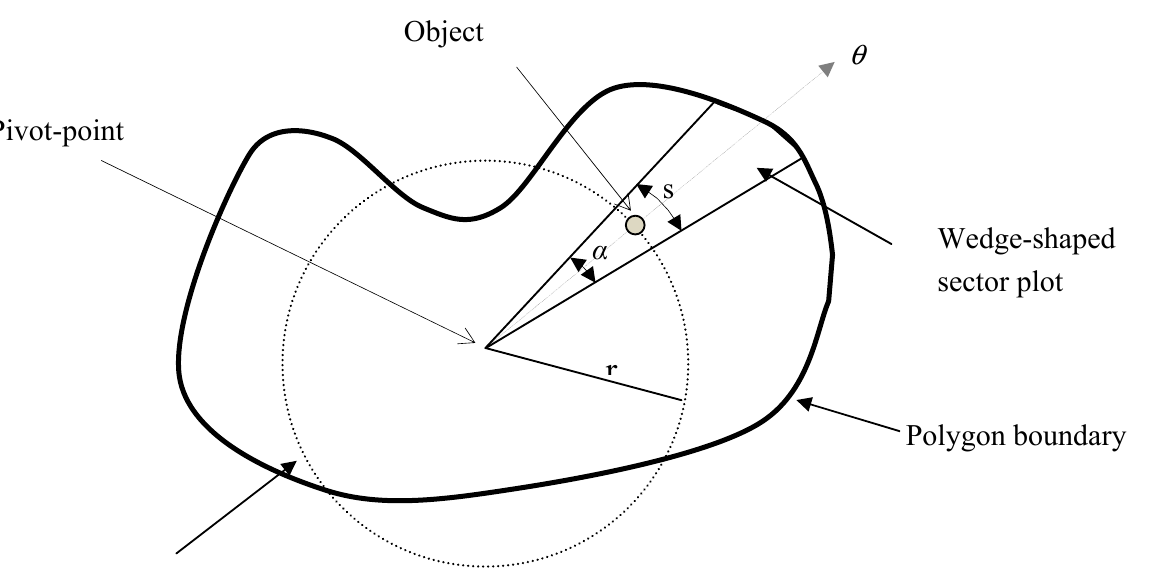
Figure 1. Schematic representation of sector sampling (Adapted from